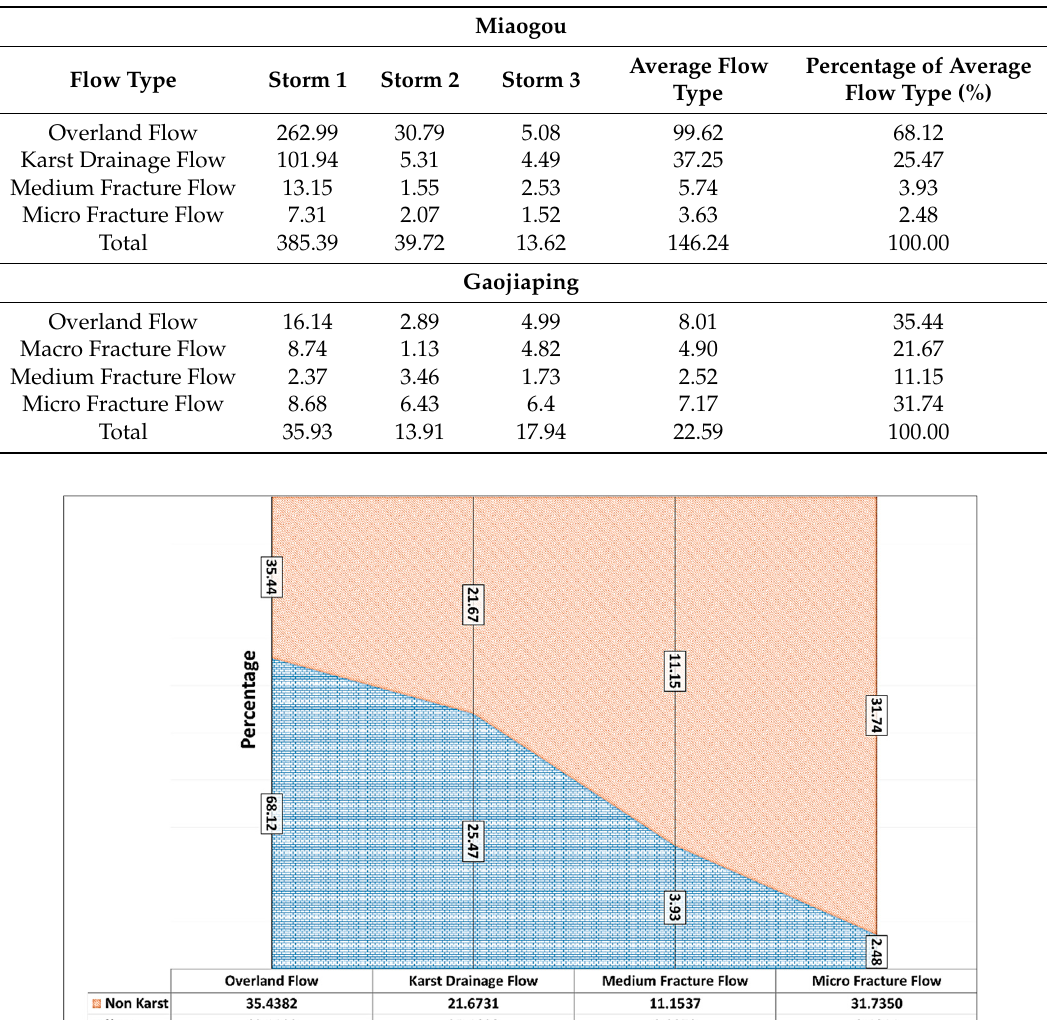
Table 6. Flow type statistics for all three storms and their average percentages.